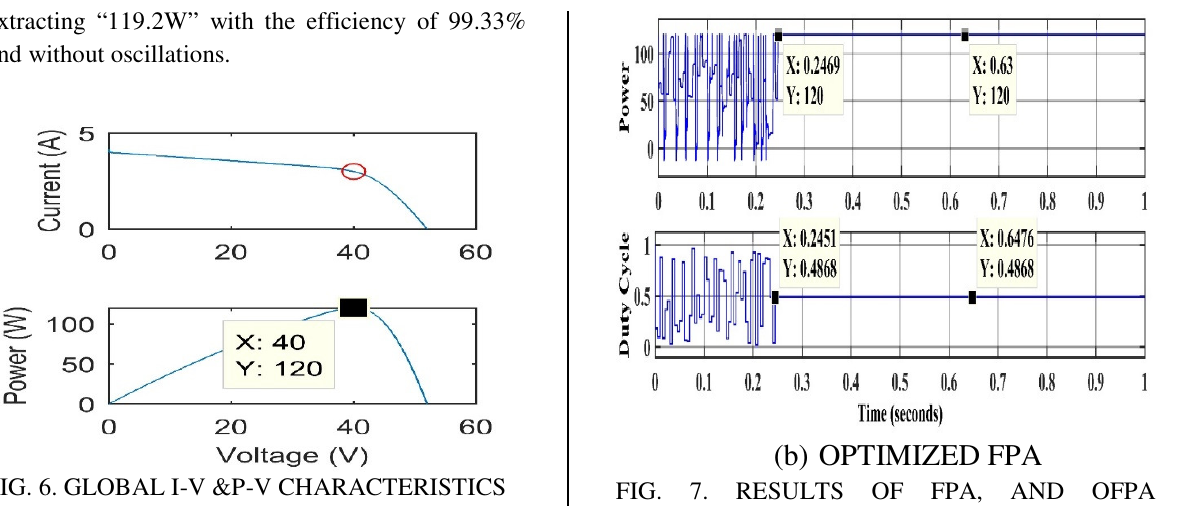
FIG. 7. RESULTS OF FPA, AND OFPA ALGORITHM AT THE ZERO SHADING CONDITION. 6.2 Case-2: Weak Partial Shading In case-2, weak partial shading is introduced. This creates two power peaks in the P-V curve of PV array. The P-V and I-V characteristic curves of a PV array for this case is displayed in Fig. 8 .